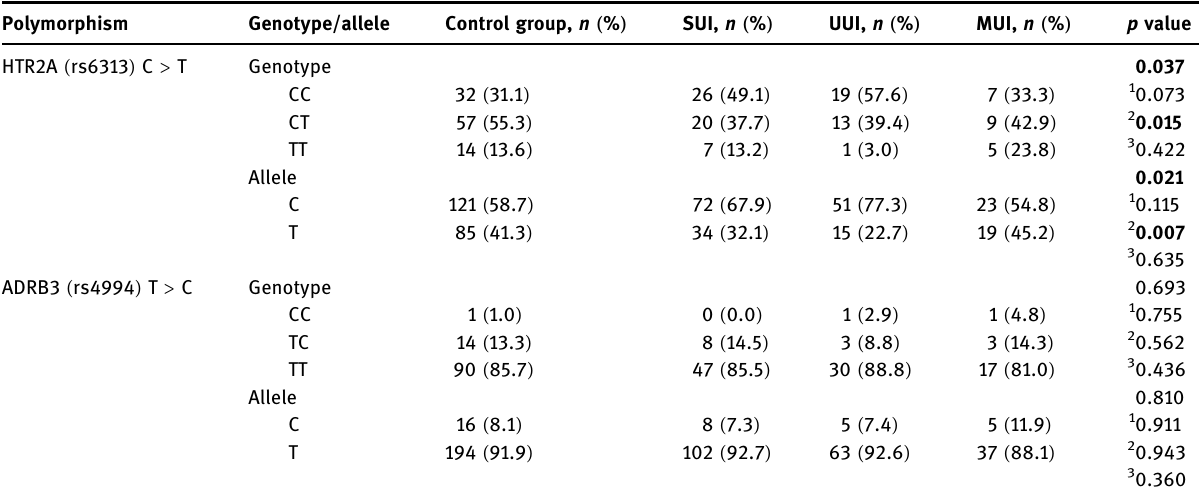
Table 2: Allele frequencies and genotype distribution among the control group ( n = 105 ) and women with di ff erent types of UI ( subgroups ) : SUI ( n = 55 ) , UUI ( n = 34 ) and MUI ( n = 21 )